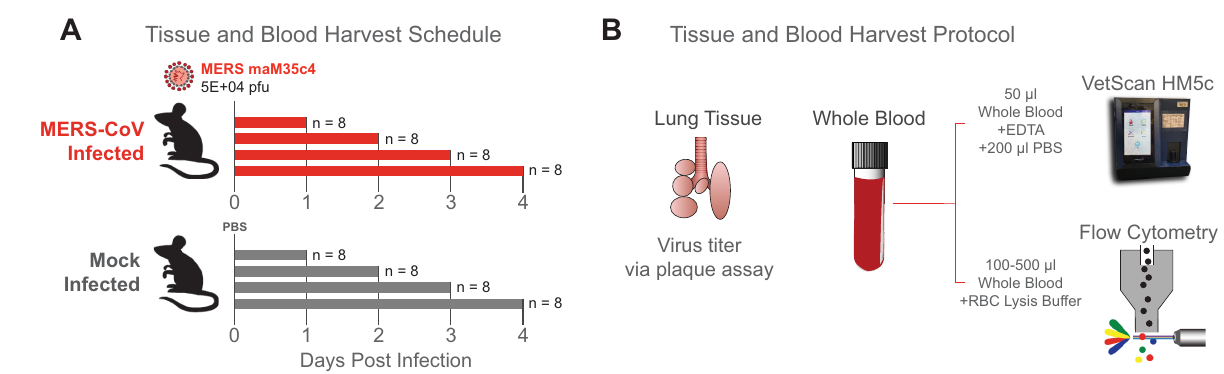
Fig 1. Experimental design. (A) Study design outlining infection and sample collection schedule. 10-week-old female 288/330 +/+ mice were mock infected (PBS, gray) or infected with 5.0 x 10 4 PFU maM35C4 (red). Per independent experiment, 4 animals/day/group were harvested on 1, 2, 3, and 4dpi (cumulative mice/time/group = 8) for virus titer and hematological analysis. This study was independently repeated once. (B) Tissue and blood harvest protocol. Per day, the inferior right lung lobe was harvested, stored at -80˚C until titration by plaque assay of clarified homogenized tissue. Whole blood was harvested, and 50 μ l was mixed with EDTA and analyzed via VetScan HM5. The remaining whole blood (100–500 μ l) was mixed with red blood cell lysis buffer, antibody stained and analyzed via multicolor flow cytometry.